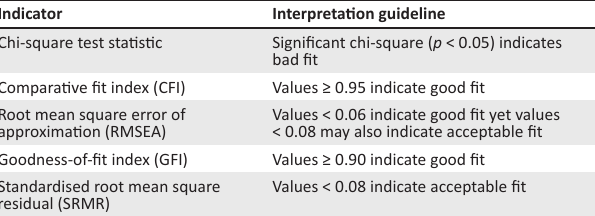
TABLE 2: Goodness-of-fit indicators for the